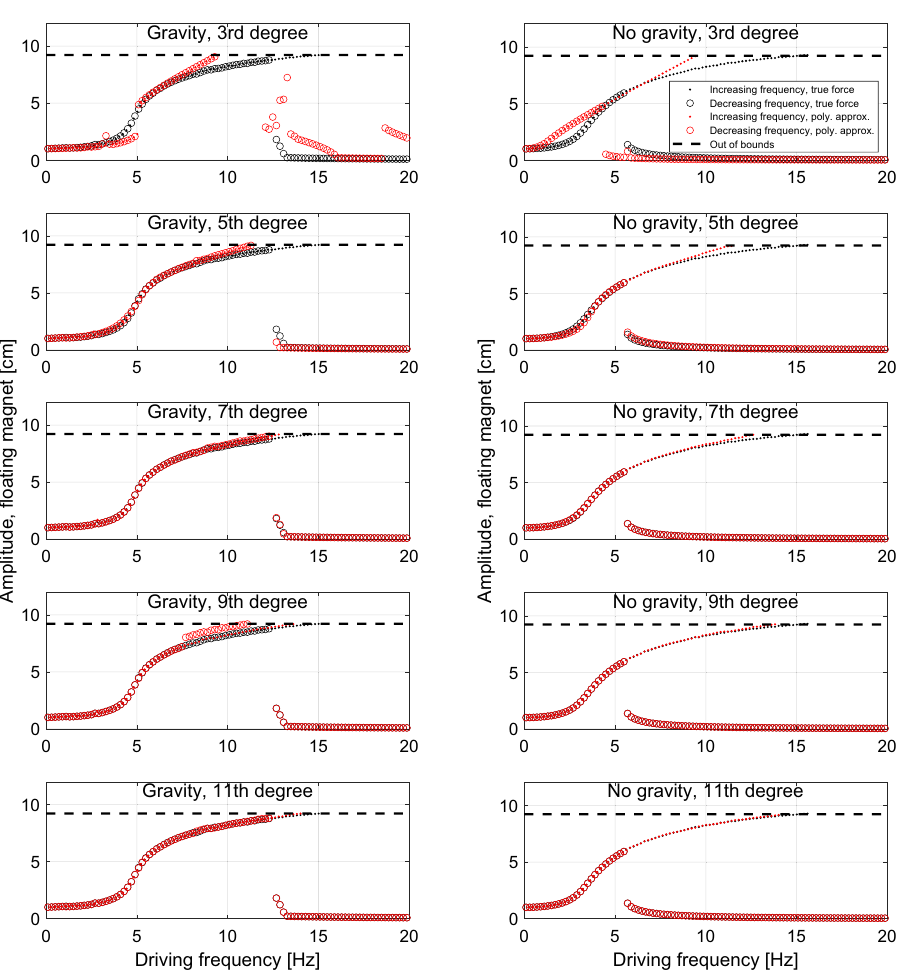
Figure 9. The frequency response from different polynomial approximation of the true force, F m , with and without